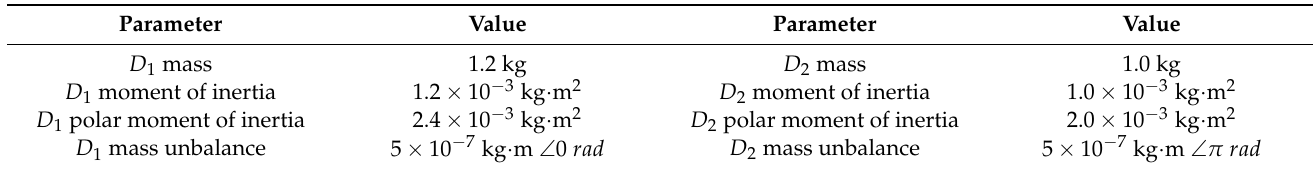
Table 2. Inertial properties of the disks and unbalance masses.